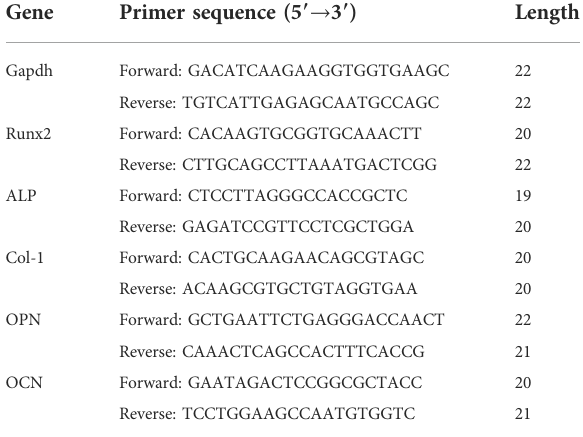
TABLE 1 List of primers used in the